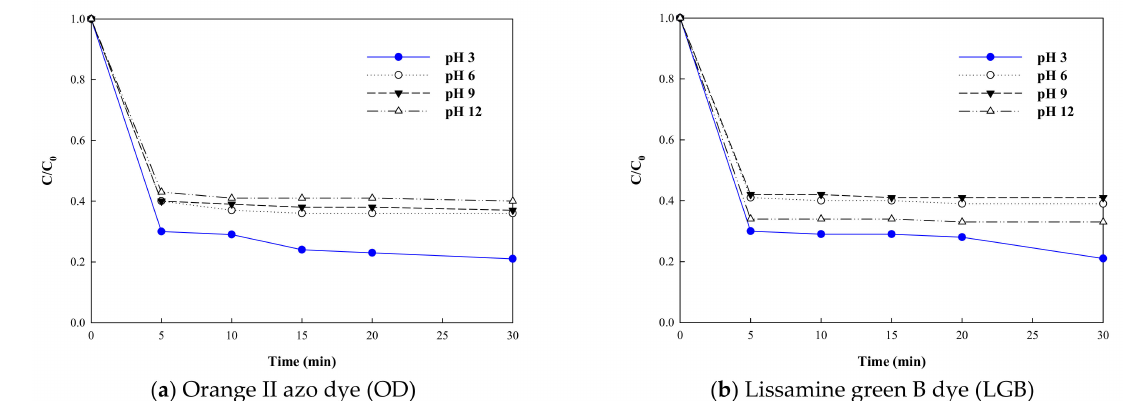
Figure 1. Effect of pH on the removal efficiency of ( a ) orange II azo dye ( b ) and lissamine green B dye by potassium